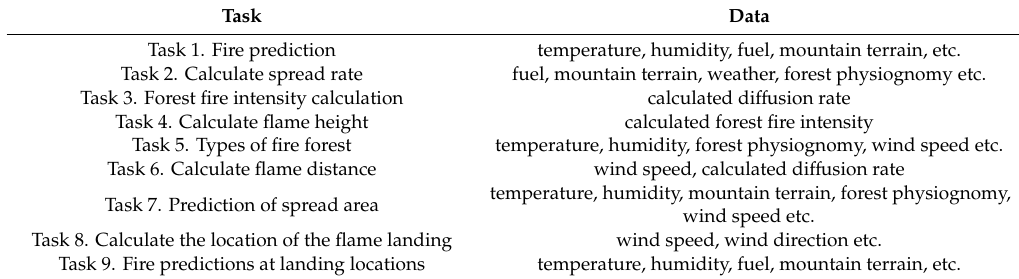
Table 1. Tasks for fire and spread range prediction, Part of the data used.